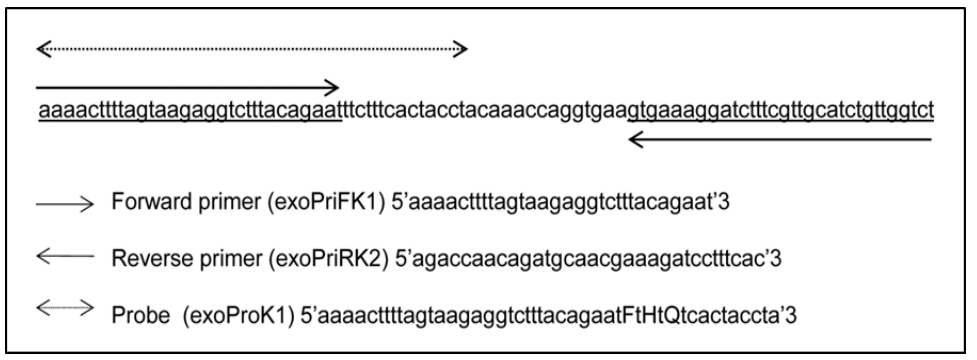
Figure 1. Partial lipL32 gene sequence used as RPA amplification target. Presentation of the RPA 90 nucleotides sized amplification locus and positions of the forward (exoPriFK1) and reversed (exoPriRK2) primers and the probe (exoProK1) used in the reaction. Nucleotides are indicated by small letters. Capitals in the probe indicate the following: F = Fluorophore (FAM), H = Tetrahydrofuran (THF) spacer, Q = Black Hole